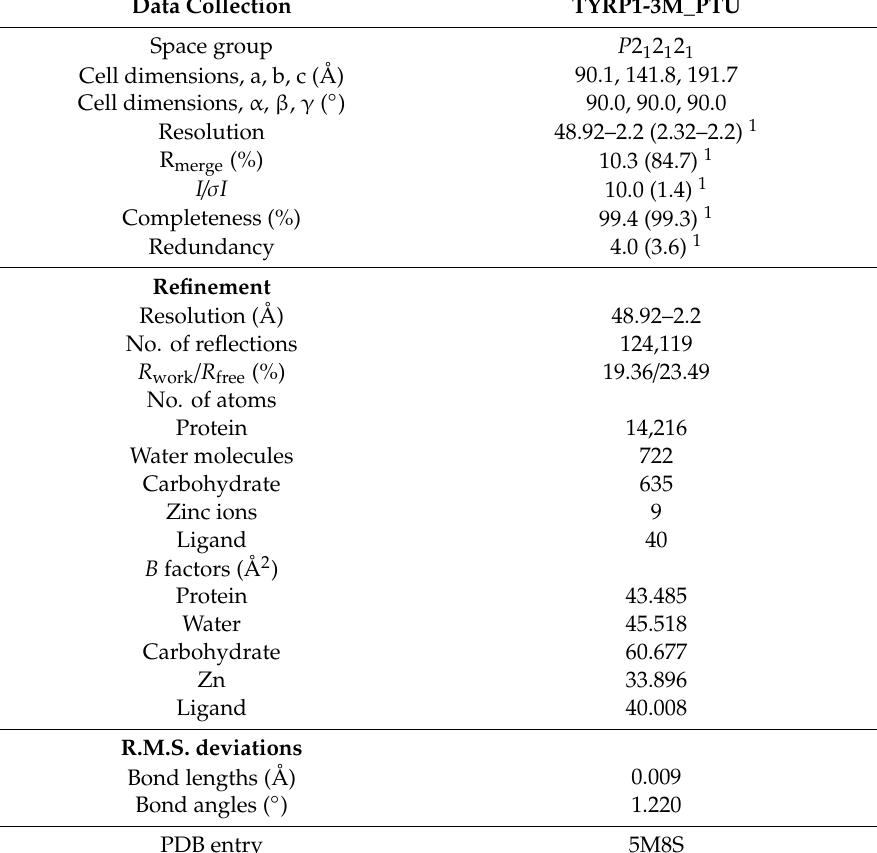
Table 1. Statistics of data collection and